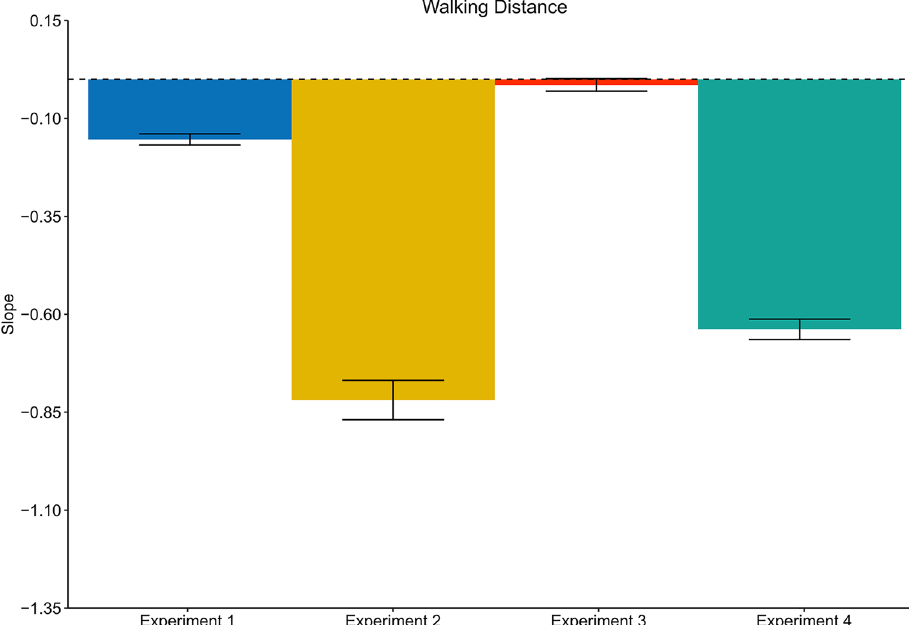
Figure 6. Average slopes representing the judged to distance ratio of walking distance judgements trials as a function of the translation gain for all experiments. Error bars represent the SEM. Experiment 1: physical walking with optic flow; Experiment 2: artificial walking with optic flow; Experiment 3: physical walking without optic flow; Experiment 4: physical walking with optic flow until prompted to stop.